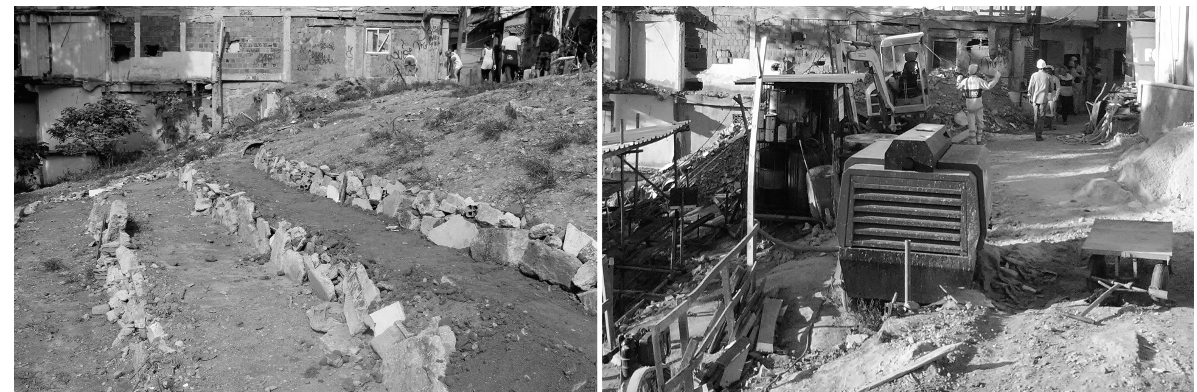
Figure 13. Laboriaux garden terraces, prepared for planting (left) and after the SMH moved onto the site (right).